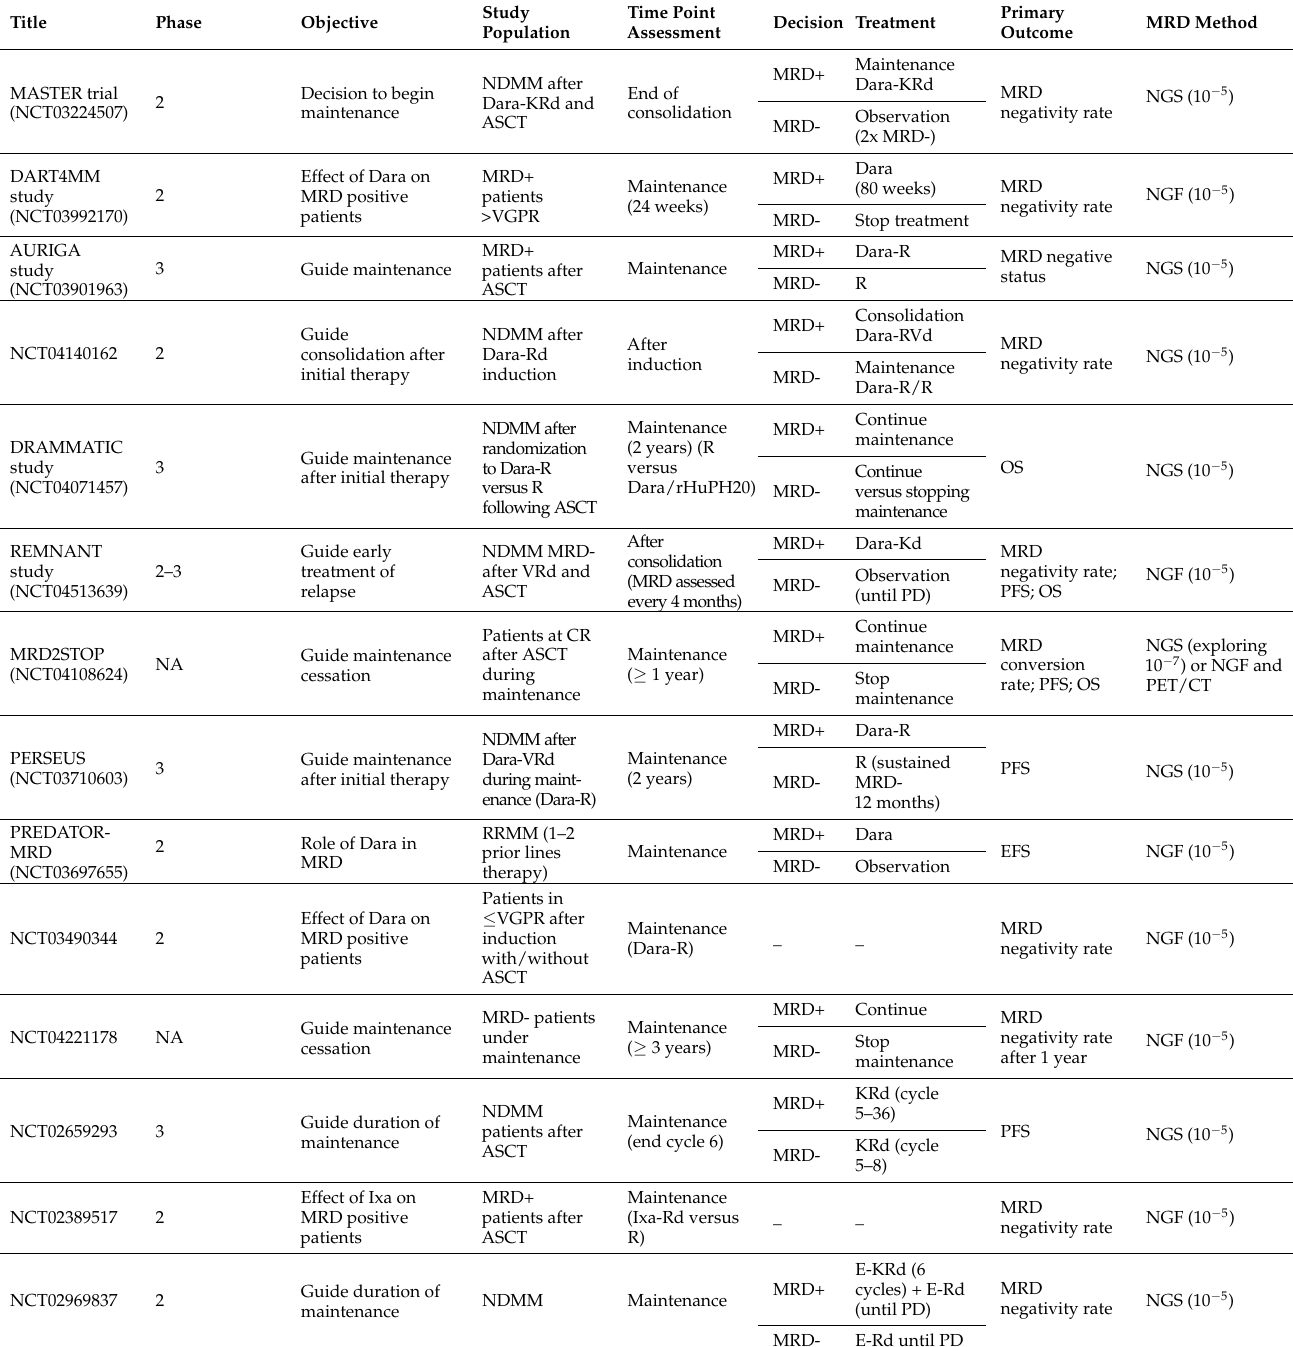
Table 2. Examples of clinical trials that use MRD testing to guide treatment decisions